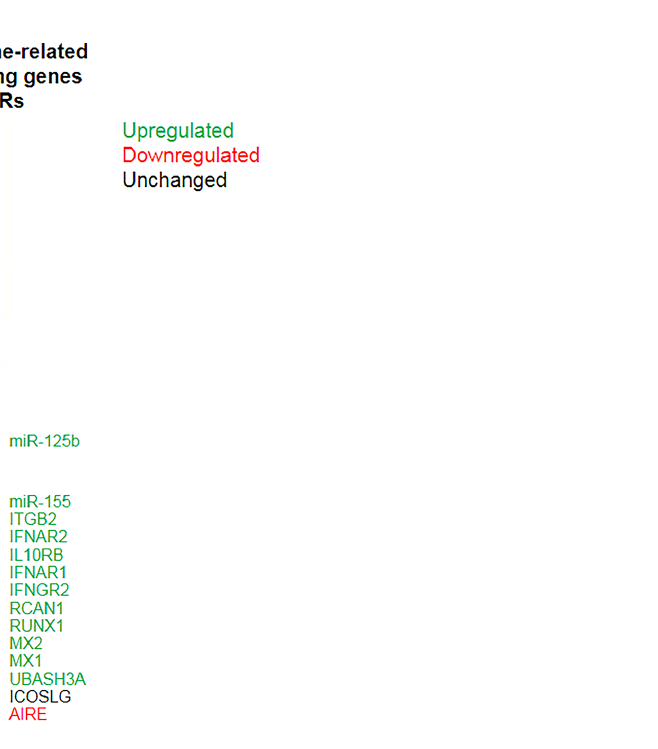
FIGURE 2 | Immune-related genes in Chr21. Alterations in the expression of Chr21 immune-related genes and miRs may directly contribute to immune dysregulation in